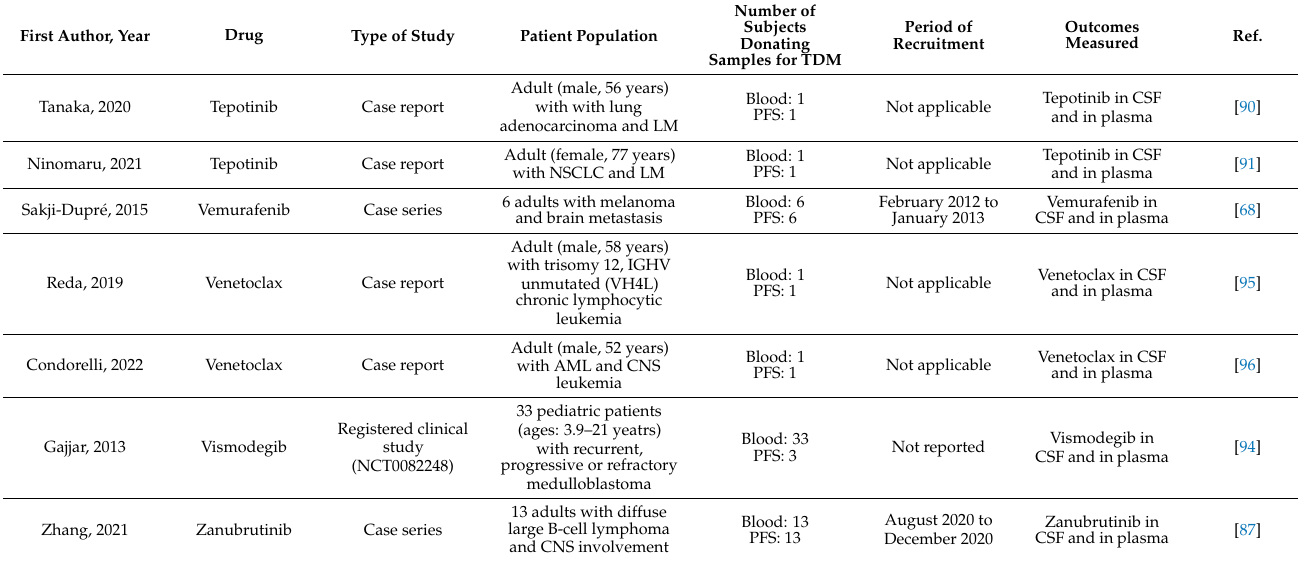
Figure 2. Summary of the results of the literature search. ( A ) Types of studies, ( B ) indications of monitoring, ( C ) monitored peripheral fluid spaces, ( D ) evaluation of clinical interest: number of manuscripts discussing the substance normalized to the number of years on the market, ( E ) marketed small-molecule, orally taken anticancer drugs with cellular protein targets without any example of being monitored in a peripheral fluid space. CSF, cerebrospinal fluid.